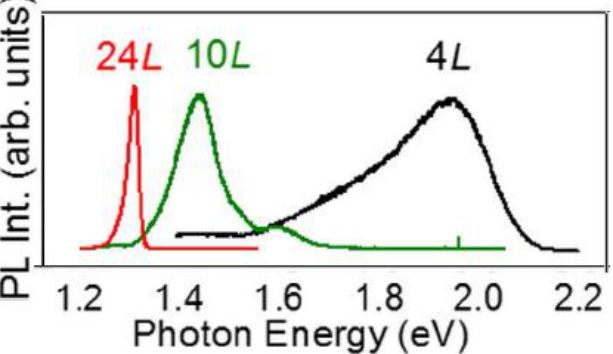
Figure 6. Normalized microphotoluminescence spectra for γ-InSe nanosheets with L = 4, 10 and 24 layers. Reproduced with permission from Ref. [69].